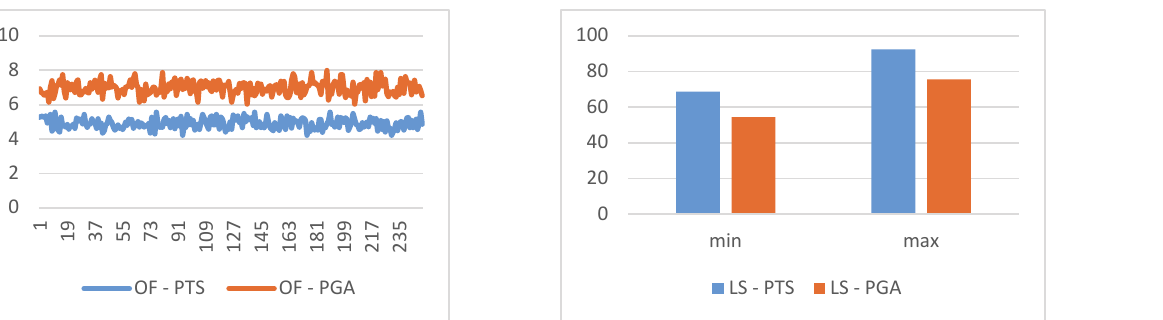
Fig. 10. Comparison of the minimum and maximum values Fig. 9. Comparison of the 250 experimental values for the OF using PTS and PGA of the service level for the 250